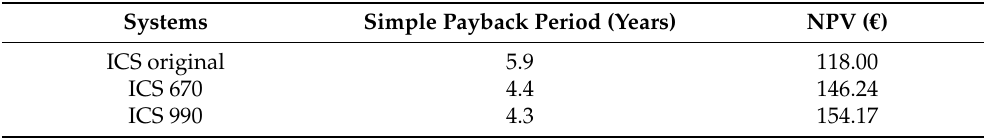
Table 5. Aggregate economical results of the redesigned systems for the two best cases/units (considering the geographic location of Chania,